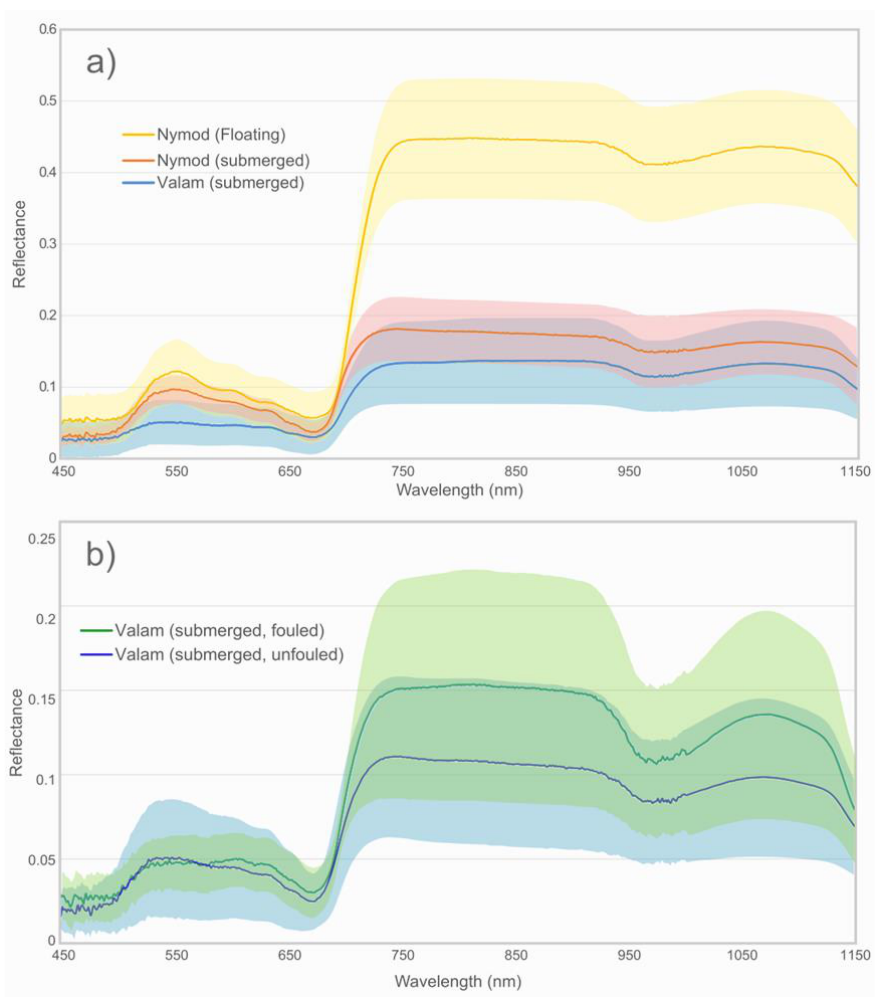
Figure 6. Examples of vegetation spectra, with one standard deviation from the mean shown as shading; ( a ) A comparison of the effect of a thin layer of water (<5 mm) on the measured reflectance of a single species and the difference in profile shape between species. Note the prominent green peak in the spectrum of Nymod near 550 nm and the red-edge around 680 nm. The measured spectra of the submerged plants are lower across the spectrum, especially so in the NIR region. Valam does not display as prominent a green peak due to its higher relative concentration of accessory pigments making the leaves appear reddish-brown. ( b ) A comparison of the effect of epibiont and sediment fouling on the same plant sample. The profile of the fouled plant has a different shape and less spectral variability in the visible region than that of the unfouled plant. Nymod = Nymphaea odorata ; Valam = Vallisnaria americana .